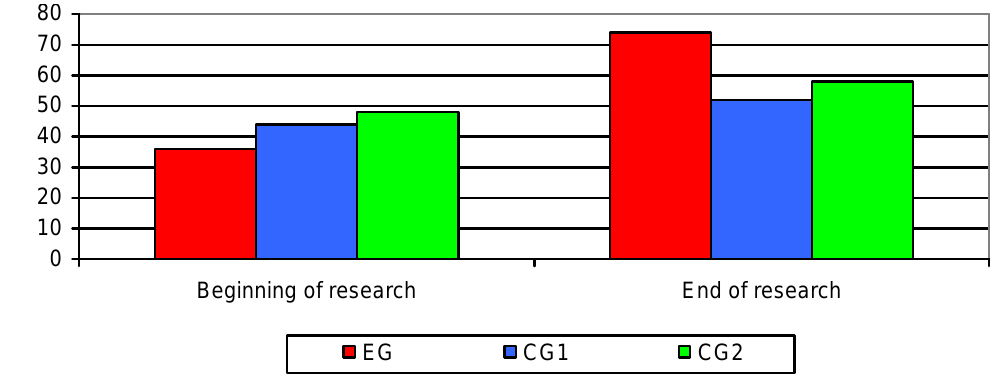
Fig.3. Comparative characteristics of operative (figures) memory indicators during